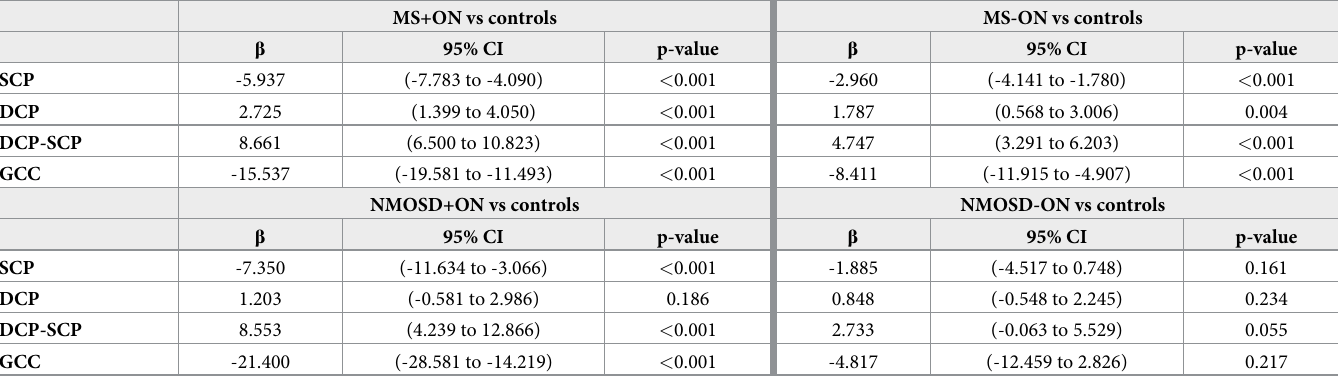
Table 3. Differences in vessel density and ganglion cell complex thickness between patients and controls.